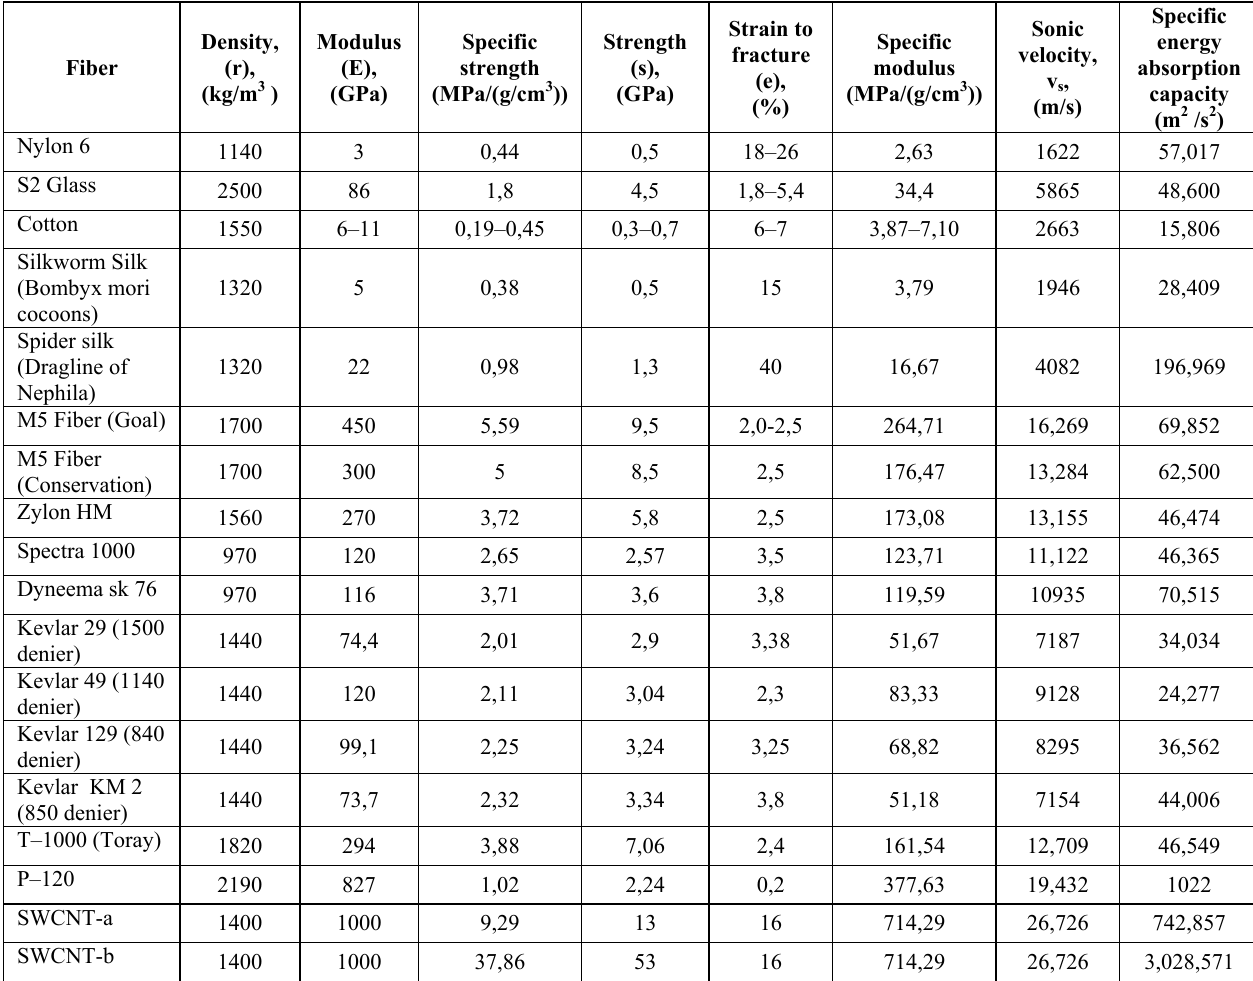
Table 1. Mechanical properties of high-performance polymeric fibers